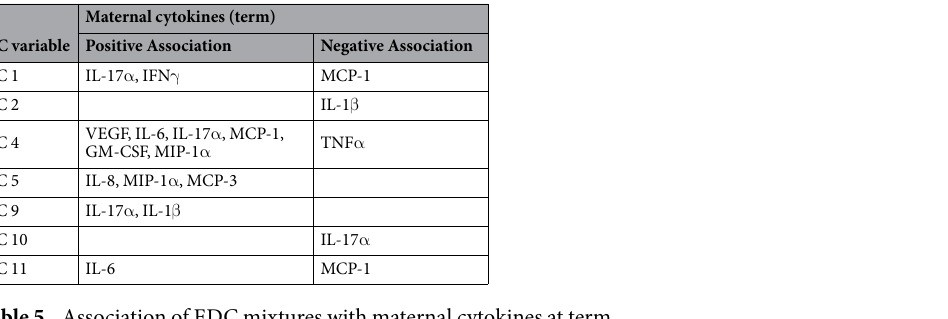
Table 5. Association of EDC mixtures with maternal cytokines at